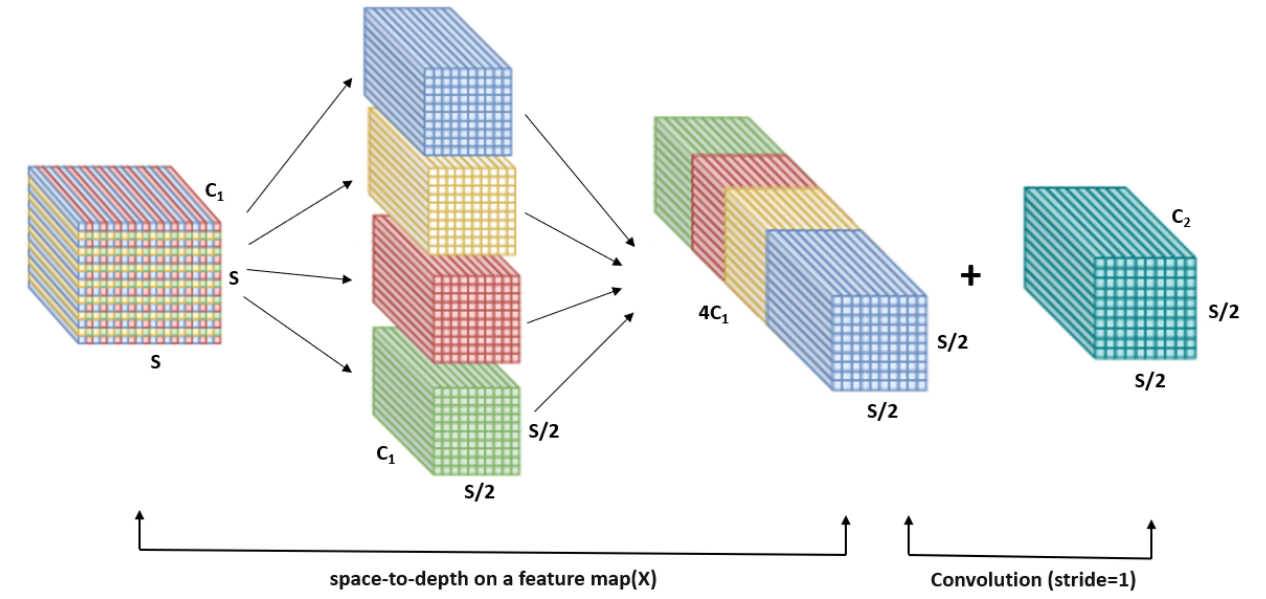
Figure 5. The overall framework of